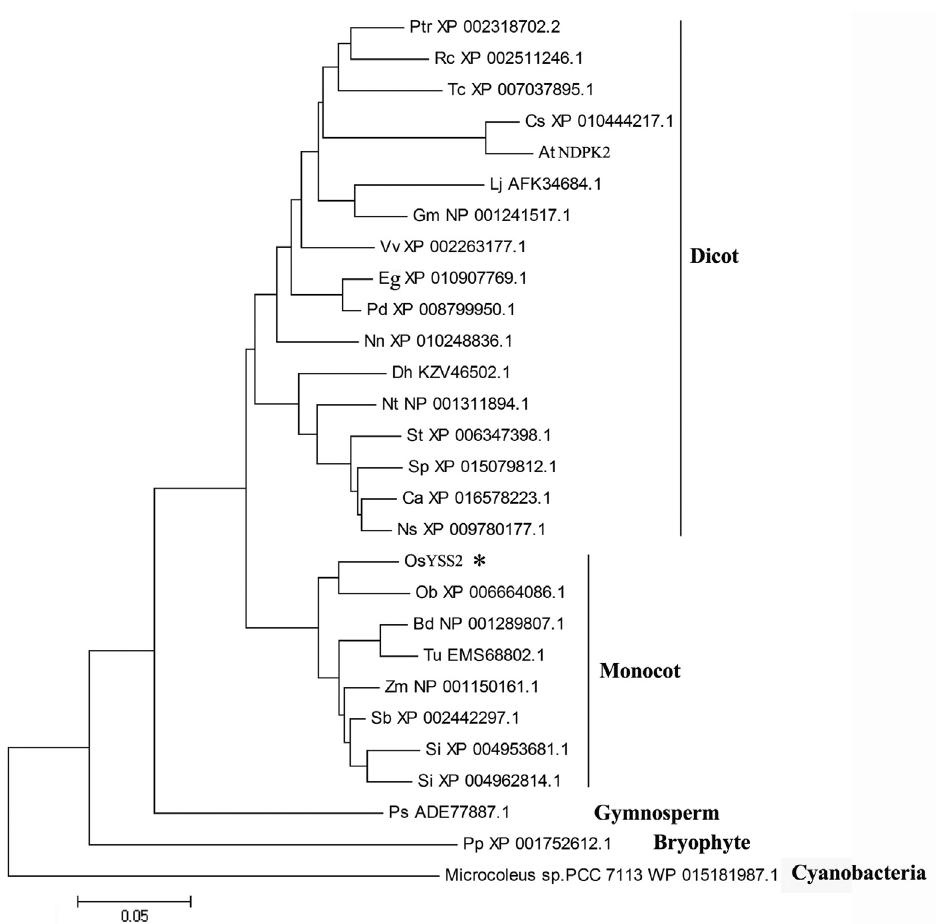
Figure 4 - Phylogenetic analysis of YSS2 and its related proteins. OsYSS2 is indicated by an asterisk . Ptr, Populus trichocarpa ; Rc, Ricinus communis ; Tc, Theobroma cacao ; Cs, Camelina sativa ; At, Arabidopsis thaliana ; Lj, Lotus japonicas ; Gm, Glycine max ; Vv, Vitis vinifera ; Eg, Elaeis guineensis ; Pd, Phoenixdactylifera ;Nn, Nelumbonucifera ;Dh, Dorcocerashygrometricum ;Nt, Nicotianatabacum ;St, Solanumtuberosum ;Sp, Solanumpennellii ; Ca, Capsicum annuum ; Ns, Nicotiana sylvestris ; Os, Oryza sativa , Ob, Oryza brachyantha ; Bd, Brachypodium distachyon ; Tu, Triticum urartu ; Zm,